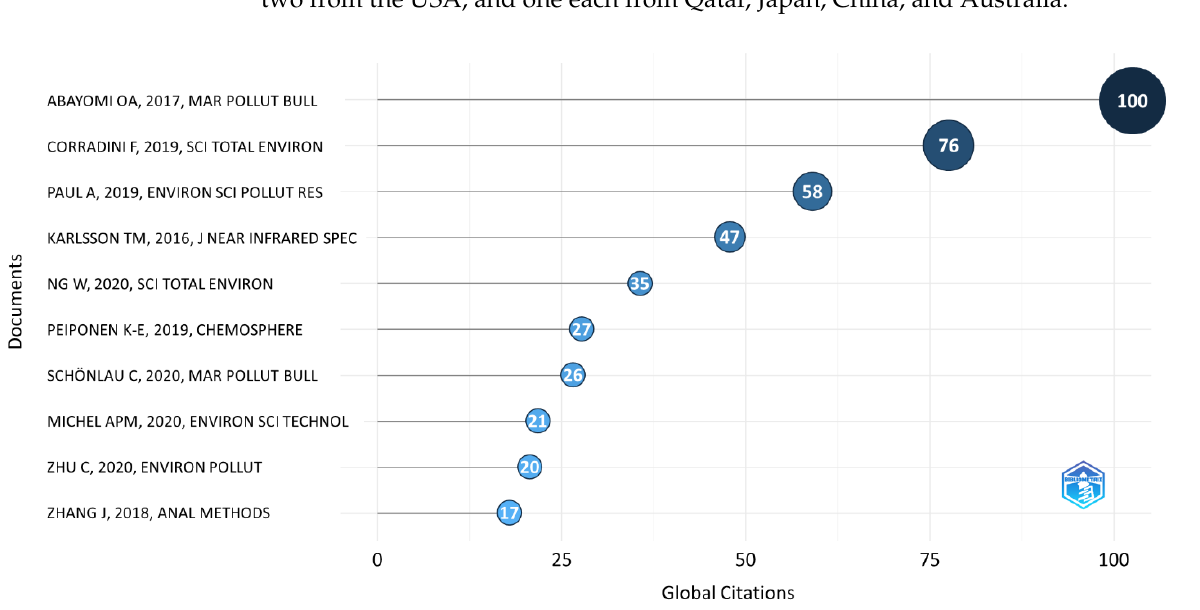
8 Figure 5. Top 10 most globally cited documents with number of citations for FTIR-related literature [40 – 49]. The figure was generated using the open-source tool Biblioshiny for Bibliometrix (Aria and